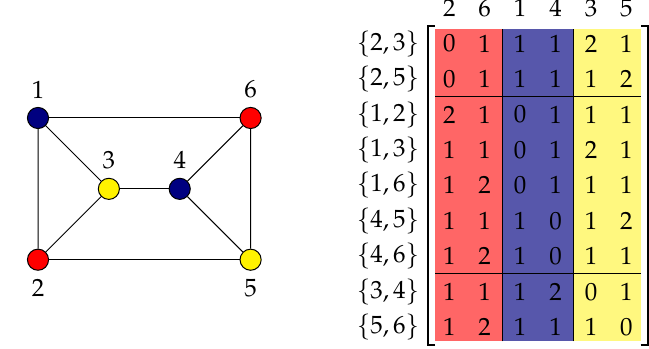
Figure 2. An illustration of the reduction from 3-C OLORING . Left : An undirected graph with a proper 3-coloring of the vertices, such that no two neighboring vertices have the same color. Right : The corresponding matrix where the columns are labeled by vertices and the rows by edges with a ( 3,3 ) -co-clustering of cost one. The coloring of the vertices determines the column partition into three columns blocks, whereas the row blocks are generated by the following simple scheme: edges where the vertex with a smaller index is red/blue (dark)/yellow (light) are in the first/second/third row block (e.g., the red-yellow edge { 2,5 } is in the first block; the blue-red edge { 1,6 } is in the second block; and the yellow-blue edge { 3,4 } is in the third